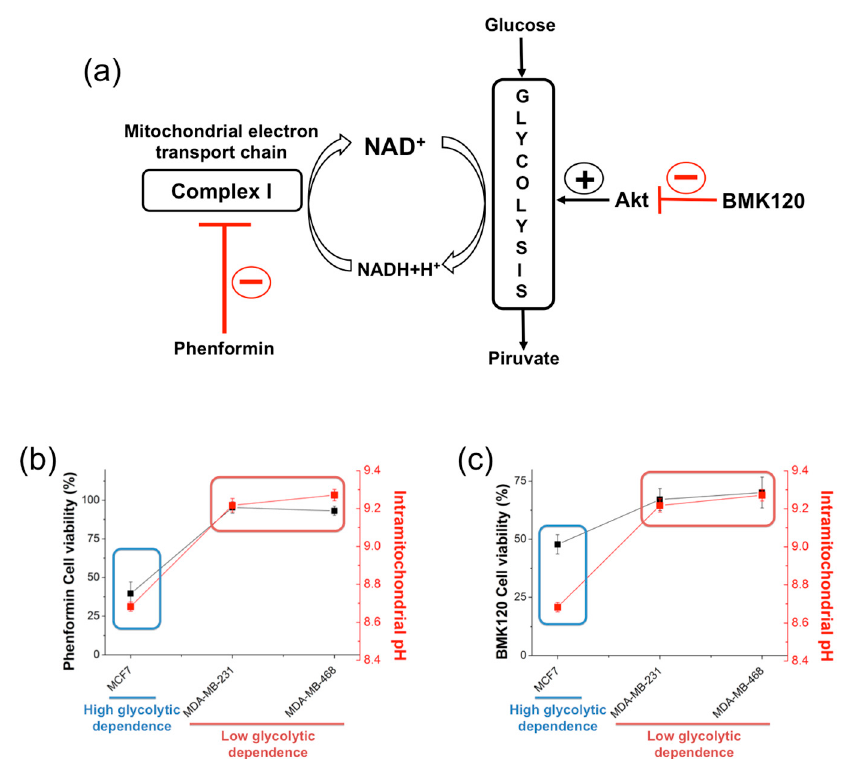
Figure 5. ( a ) Regulatory mechanism for the effect of BMK120 and phenformin. ( b and c ) Correlation of the mitochondrial pH (red) with cell viability upon treatment with BMK120 ( b ) and phenformin ( c ) in the MCF7, MDA-MB-231, and MDA-MB-468 breast cancer cell lines. This correlation clearly highlights two different metabolic behaviors with high (MCF7) or low (MDA-MB-231 and MDA-MB-468) glycolytic dependence.